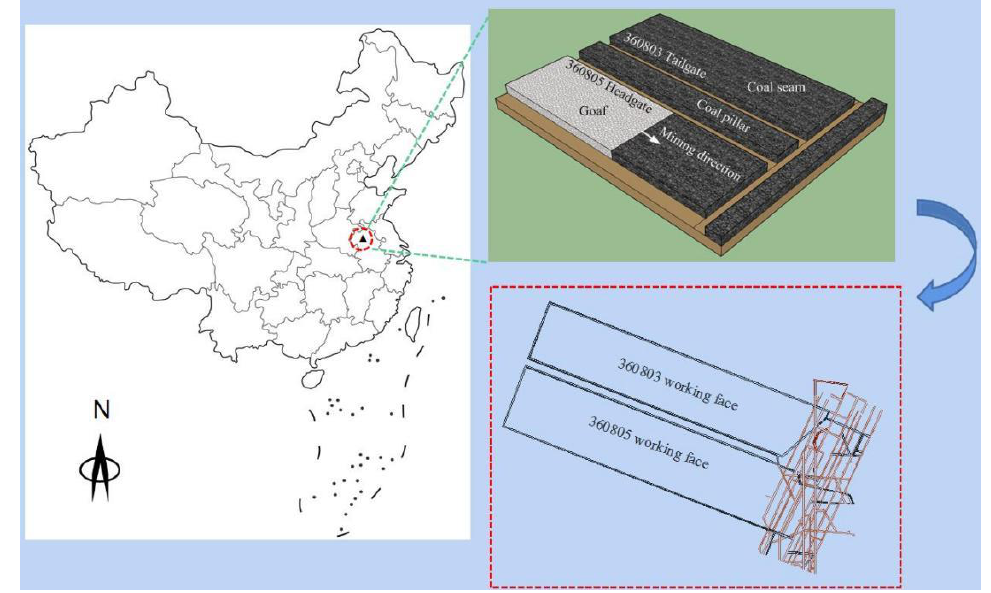
Figure 1. Plane position graph of 360,803 airway and 360,805 working face.